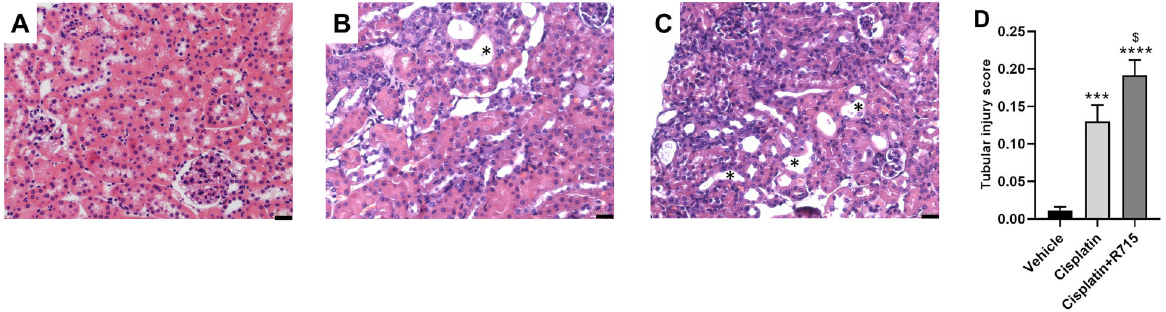
Figure 5. Kinin B1 receptor antagonism worsens cisplatin-induced tubular injury. Hematoxylin and eosin staining, representative images of vehicle ( A ), cisplatin ( B ), and cisplatin + R715 ( C ) groups. Asterisks indicate tubular dilation. Scale bars, 25 m m. Tubular injury score ( D ) was determined based on the percentage of tubules showing luminal casts, cell detachment, or dilation. Data are reported as means ± SE (n=6 per group). ***P o 0.001, ****P o 0.0001 compared to the vehicle group; $ P o 0.05 compared to the cisplatin group (one-way ANOVA followed by post hoc Tukey ’ s